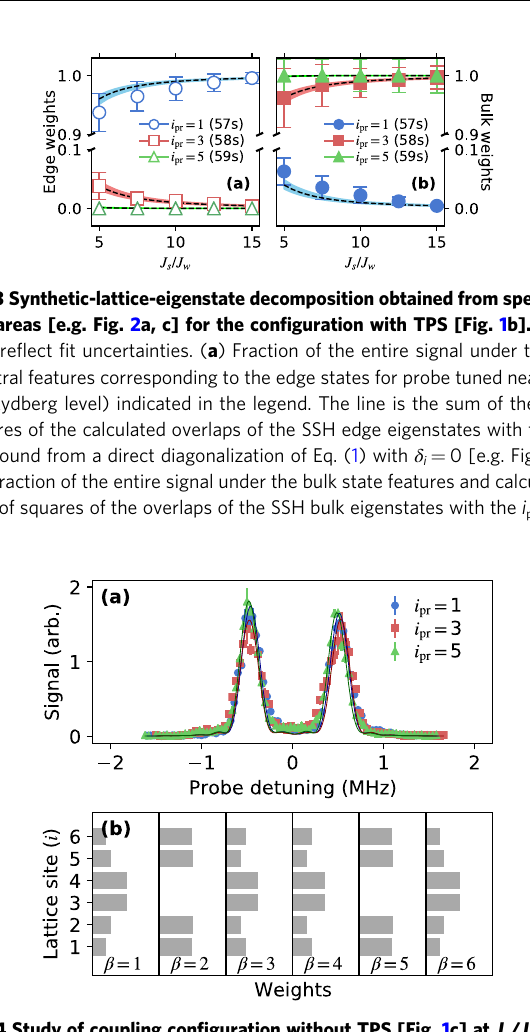
Fig. 4 Study of coupling con fi guration without TPS [Fig. 1c] at J s / J w = 5. ( a ) Rydberg excitation spectra when coupling to i pr = 1(57 s ), i pr = 3(58s), and i pr = 5(59s). Probe detuning ( Δ i ) is from the undressed Rydberg level. pr Lines are the same as in Fig. 2. Error bars denote one s.e. of the mean. ( b ) (cid:4) (cid:3) j 2 , obtained from direct diagonalization State decomposition weights, j β j i of Eq. (1). All states have appreciable bulk character.